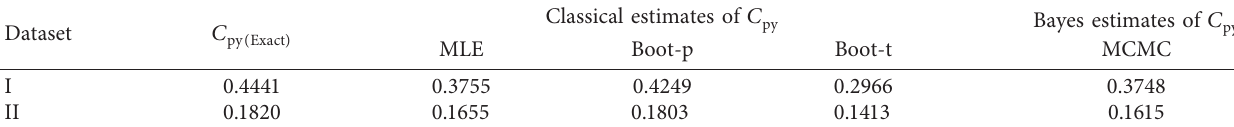
Table 2: Different point estimates of C